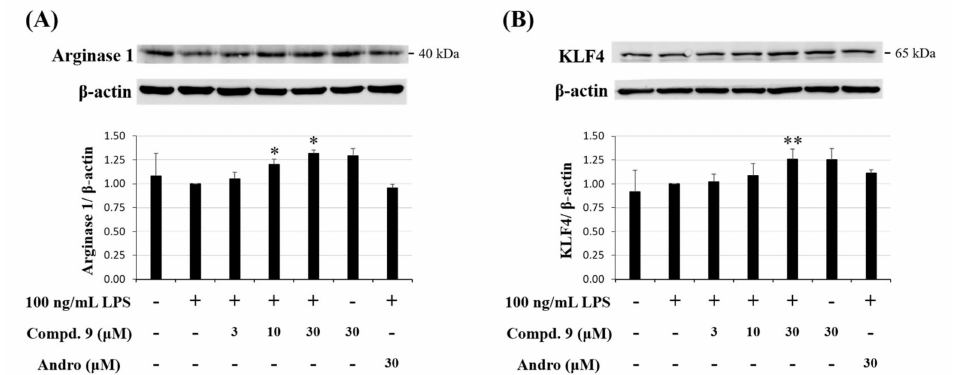
Figure 10. E ff ect of otogirinin A ( 9 ) on M2 polarized macrophages in LPS-stimulated RAW264.7 macrophages. ( A , B ) Expression of arginase 1 and KLF4 was determined by Western blot analysis. Data expressed as means ± SEM (n = 3). Asterisks indicate significant di ff erences (* p < 0.05 and ** p < 0.01) from the (media + LPS) control group.